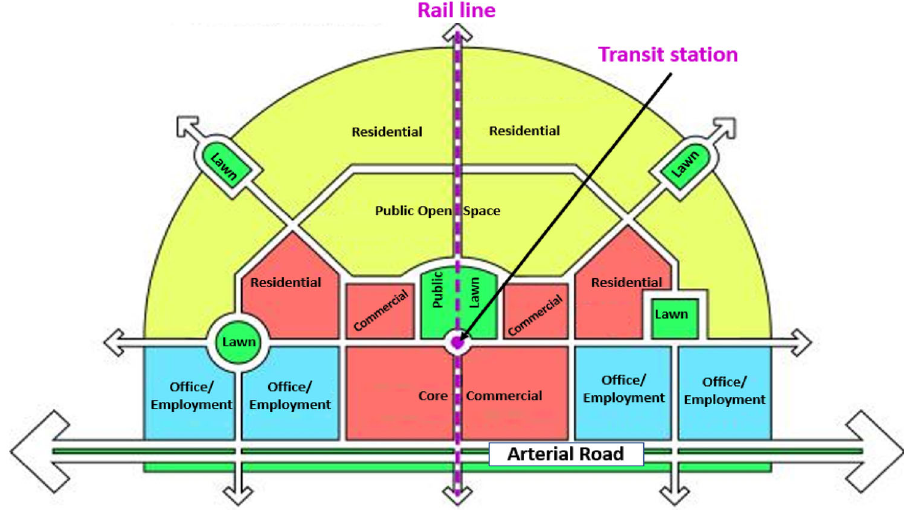
Fig. 1 A basic structure of the TOD community. Adapted from Mingqiao et al.